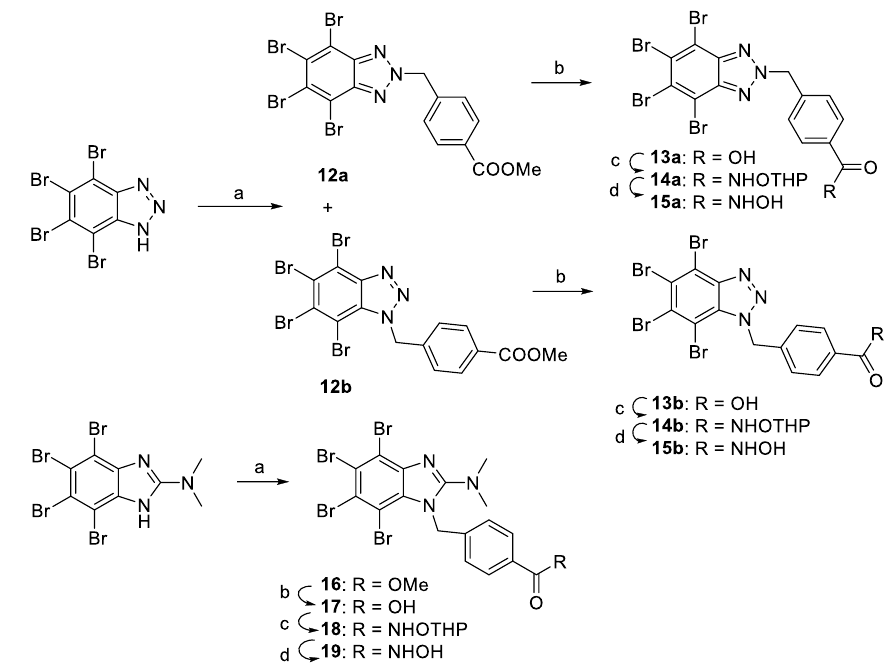
Scheme 4 a . Synthetic route for compounds 13-19 .